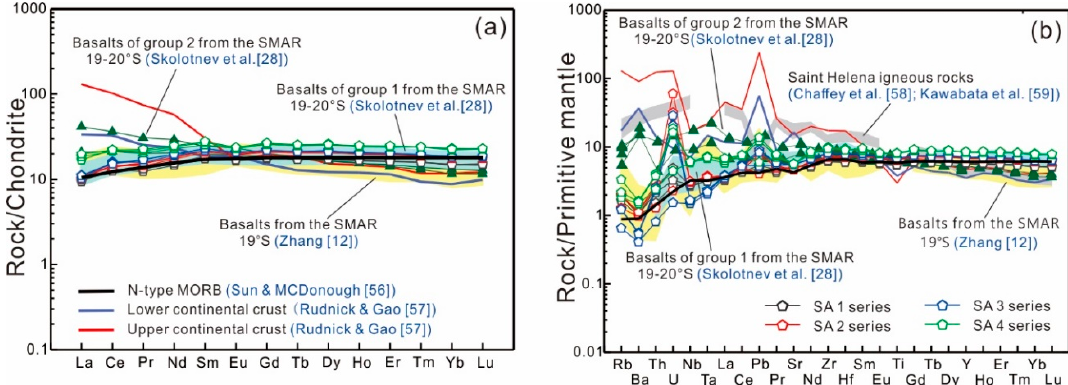
Figure 6. ( a ) Chondrite-normalized REE and ( b ) primitive mantle-normalized multielement diagrams of the SMAR basalt samples. The chondrite and primitive mantle normalization and N-type MORB data are from [56]. Upper and lower continental crust data are from [57]. Data for basalts from the SMAR 19°–20°S are from [12,28]. Data for igneous rocks from the Saint Helena islands are from [58,59].